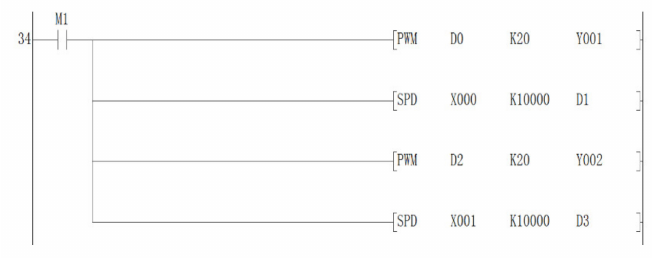
Figure 15. PLC program line diagram of the cutter speed.